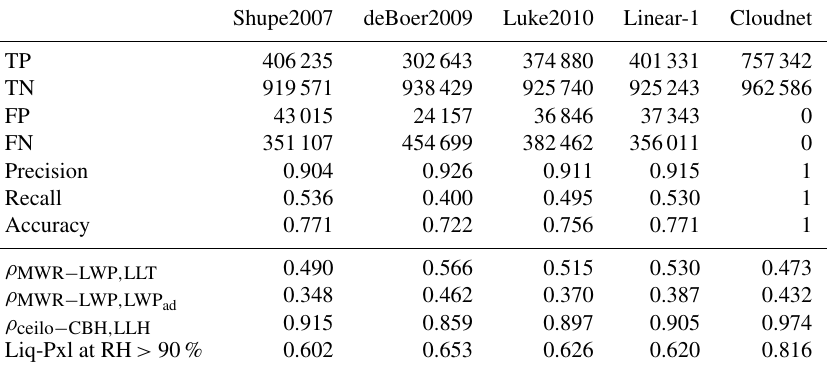
Table 3. Error matrix, performance metrics, and correlation coefficients for ceilometer CBH vs. LLH, MWR-LWP vs. LLT, and MWR-LWP vs. LWP ad , cor for the entire ACCEPT data set. The statistic includes only valid